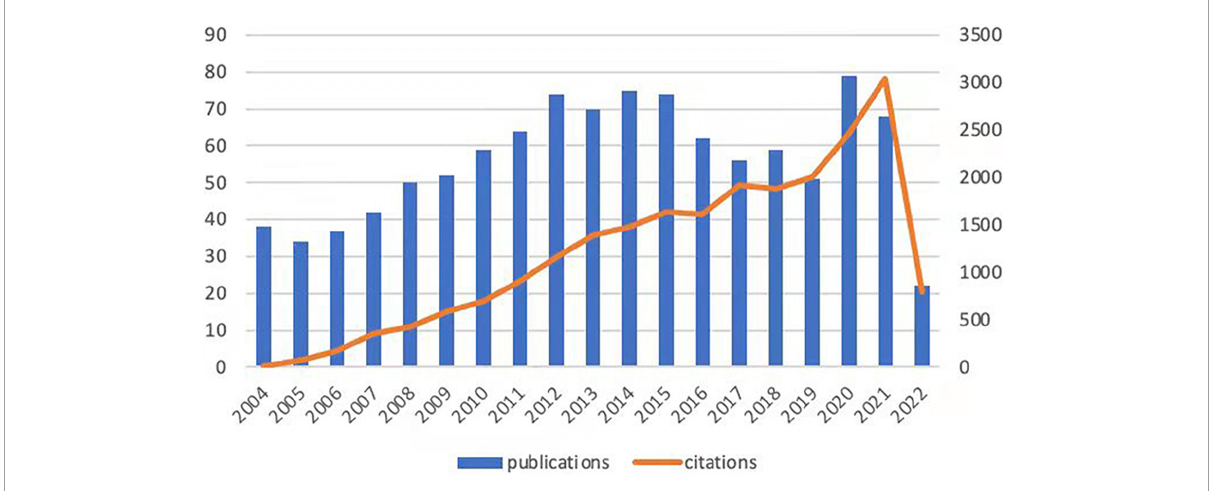
FIGURE1 Trends in the publication and citation frequency of intestinal I/R-related literature (2004–2022). The number of publications fluctuates between 30 and 80, with a maximum value in 2020 and an average of more than 66 in the last decade. The overall upward trend in citation frequency is